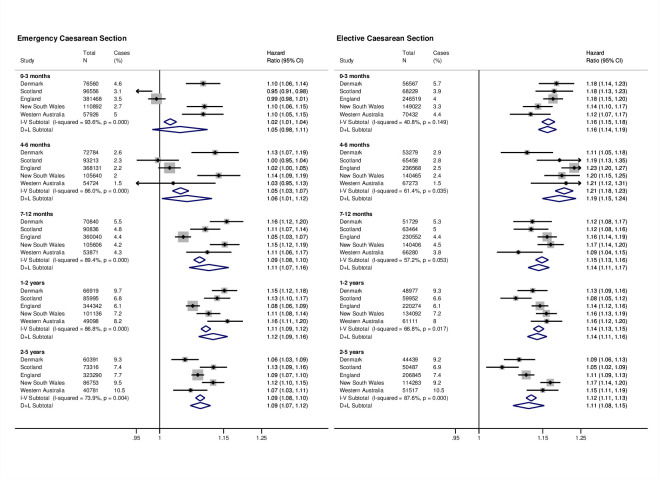
Site-specific and meta-analysis HRs for infection-related hospitalisations by age at first occurrence.Estimates are from first event models adjusted for sex, gestational age, birth weight z-score, smoking during pregnancy, maternal age at birth, parity, area level deprivation, birth year, medical indication for type of delivery, and season of birth. Reference is vaginal births. Estimates for England based on follow-up time until first infection-related hospitalisation admission as data on exact date of birth were not available. CI, confidence interval; D+L, DerSimonian and Laird random effects model; HR, hazard ratio; I-V, inverse-variance weighted fixed effects model.